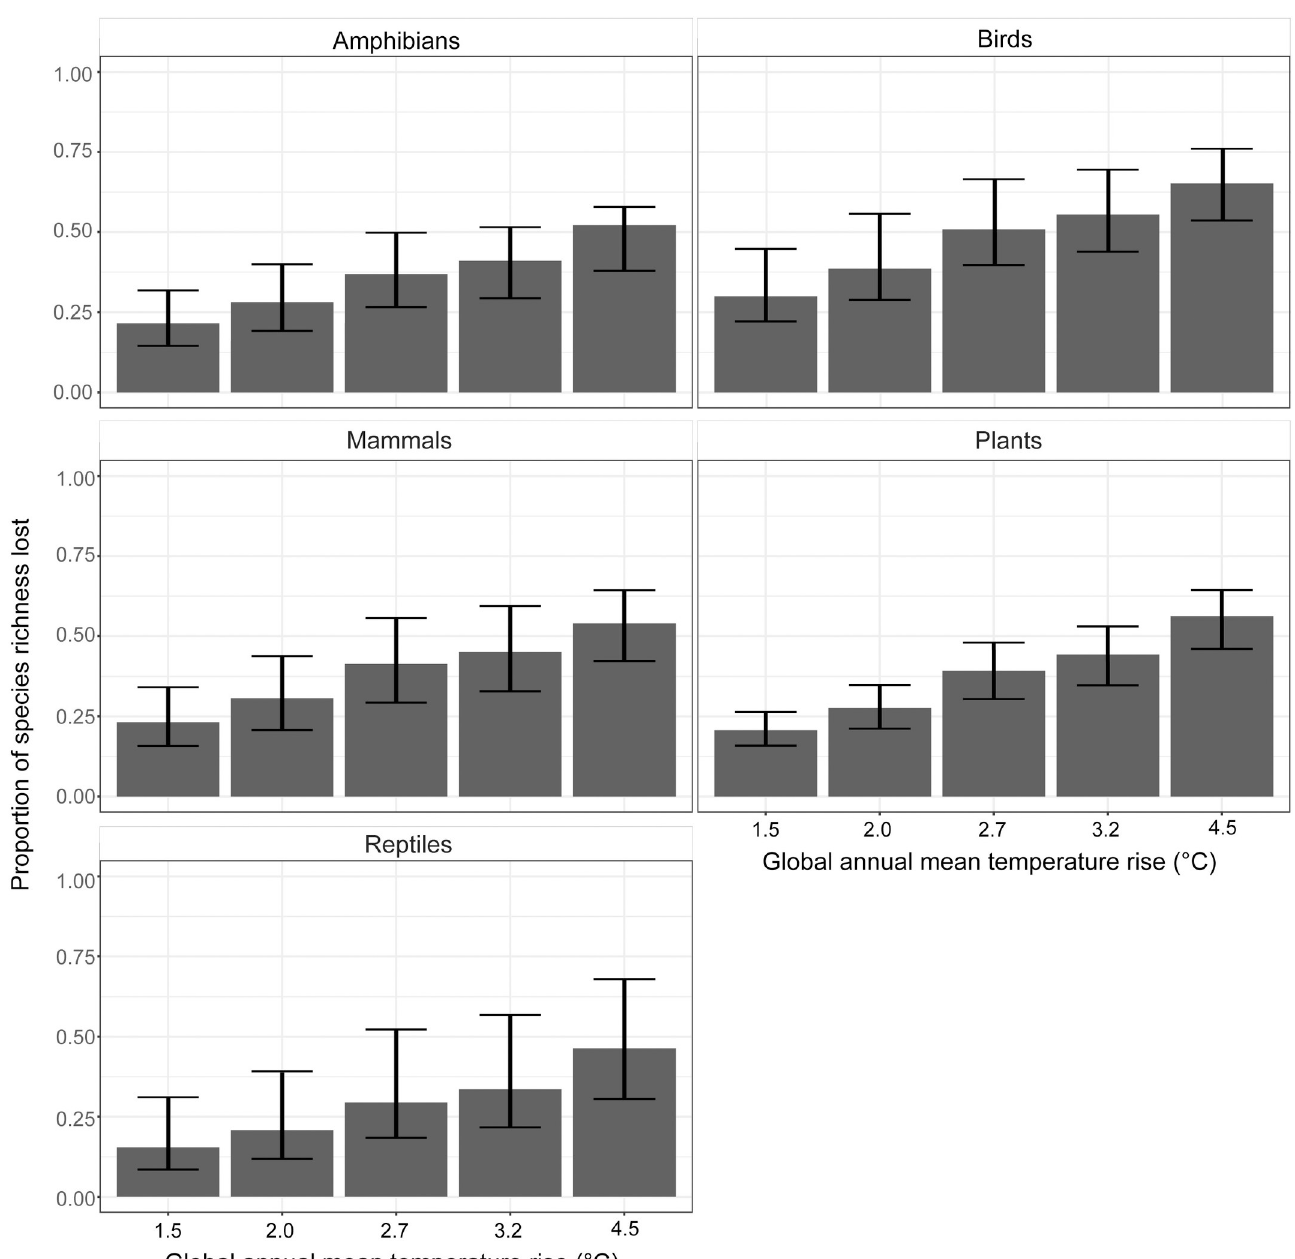
Fig 2. Basin-average proportion of species richness lost with different levels of global temperature rise. Data are presented as the mean across 21 GCMs, with error bars indicating the 10 to 90%